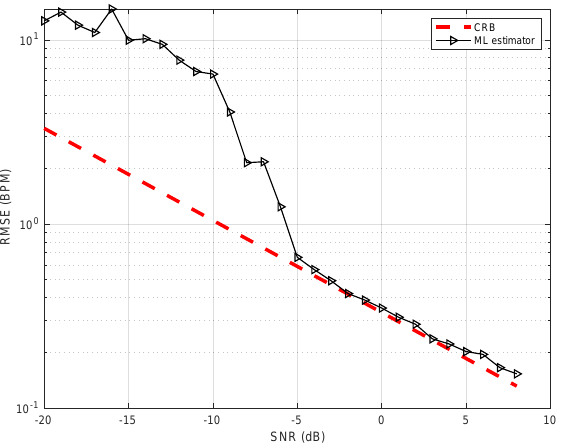
Figure 1. Root mean squared error vs. CRB for number of harmonics M = 1 and fundamental frequency of 0.312 Hz.